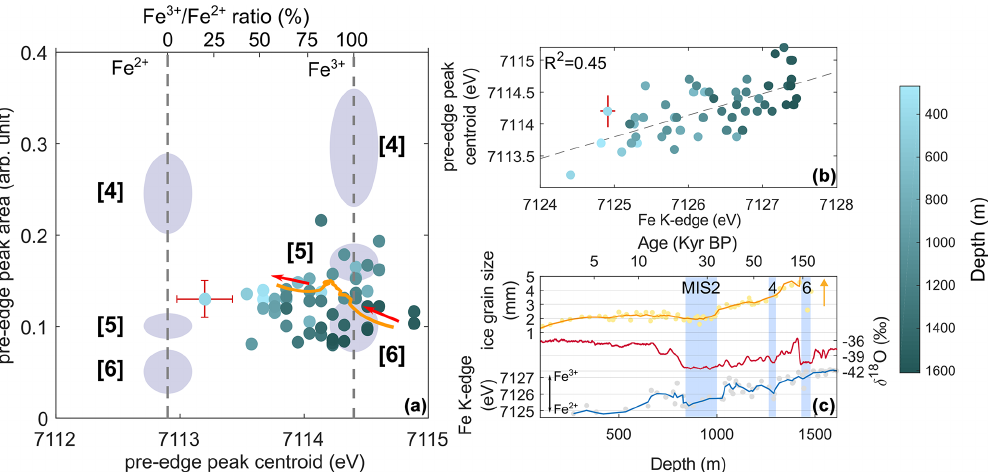
Figure 4. XANES results from the analysis of dust in TALDICE. (a) Analysis of the Fe K-pre-edge spectral region. The intensity and energy position of the pre-edge peak are shown following the scheme proposed by Wilke et al. (2001). Ellipses and numbers in square brackets refer to the coordination of Fe and vertical lines to its two oxidation states; the orange curve represents the trajectory of the samples along the core, it was calculated as in Fig. 2 (arrows from deep to shallow). (b) A comparison between the energy position of the pre-edge peak and the main K-edge transition (see Fig. S1 for details). (c) The energy position of the Fe K-edge transition (blue line) vs. the isotope composition of ice (red line) (Stenni et al., 2011) and ice grain size (yellow line) (Montagnat et al., 2012); the arrow indicates the observed but not quantified ice crystals larger than 40cm found below 1481m deep; blue bands highlight MIS 2, MIS 4 and MIS 6. For each panel one point presents mean error bars (not visible in panel c because of